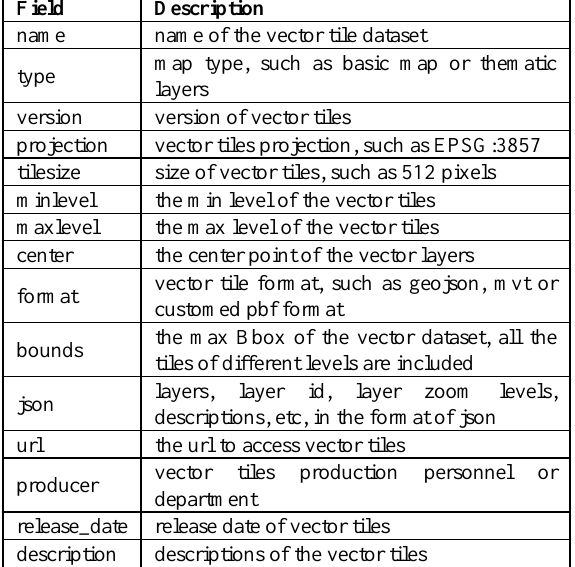
Table 1 . Metadata for vector tiles